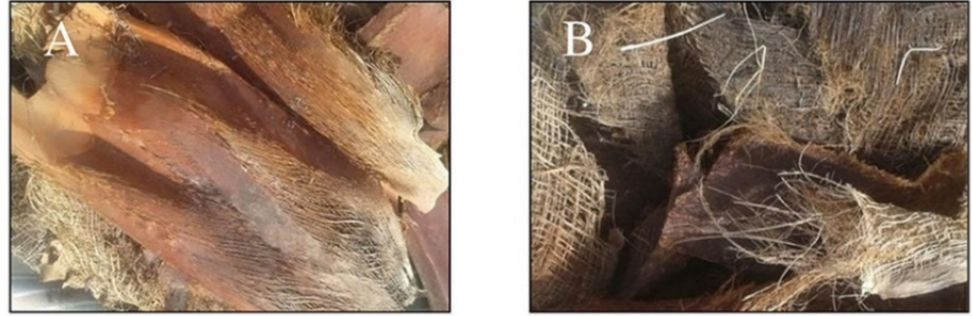
Figure 1. Lignocellulose material from Phoenix dactylifera L. young ( A ) and old ( B ), called in Tunisia ‘lifs’.